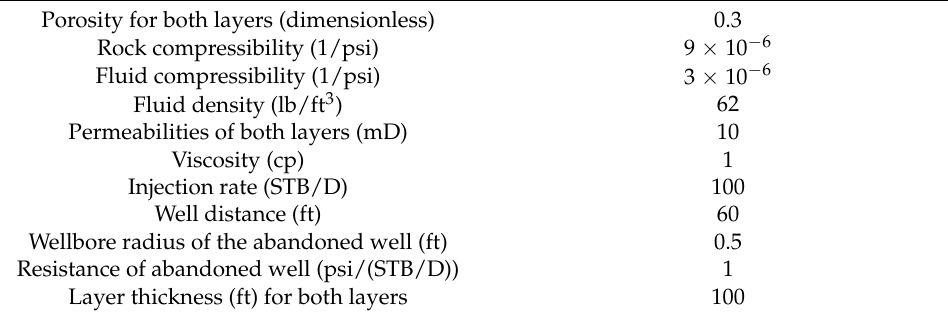
Table 1. Reservoir and fluid properties of the problem. Porosity for both layers (dimensionless) 0.3 Rock compressibility (1/psi) 9 × 10 − 6 Fluid compressibility (1/psi) 3 × 10 − 6 Fluid density (lb/ft 3 ) 62 Permeabilities of both layers (mD) 10 Viscosity (cp) 1 Injection rate (STB/D) 100 Well distance (ft) 60 Wellbore radius of the abandoned well (ft) 0.5 Resistance of abandoned well (psi/(STB/D)) 1 Layer thickness (ft) for both layers